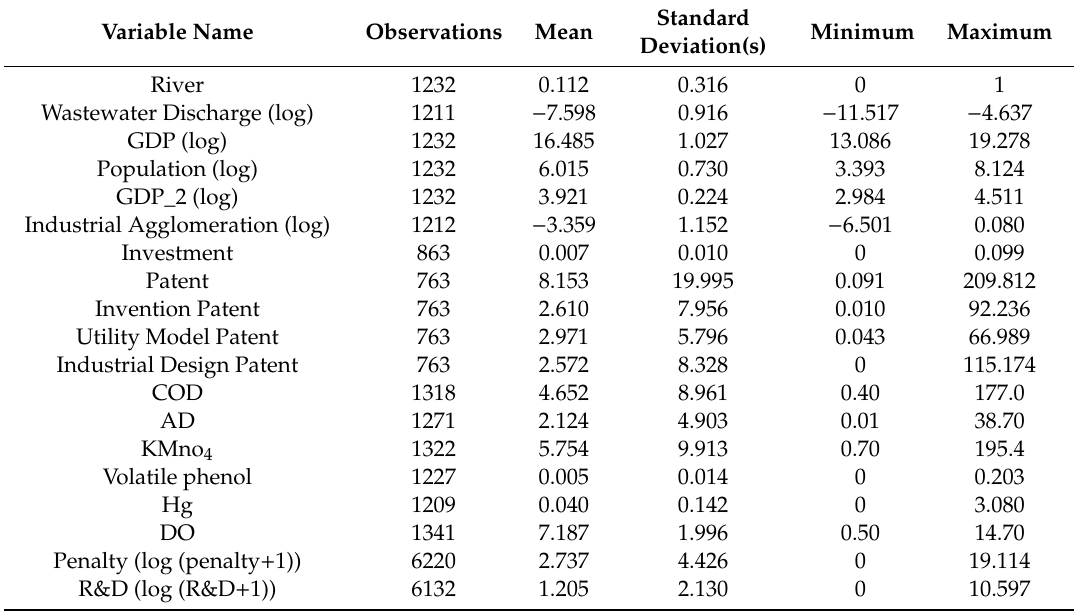
Table 2. Descriptive statistics of major